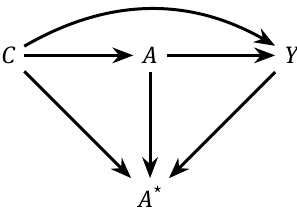
Figure 2: Differential misclassification in the measurement of exposure A